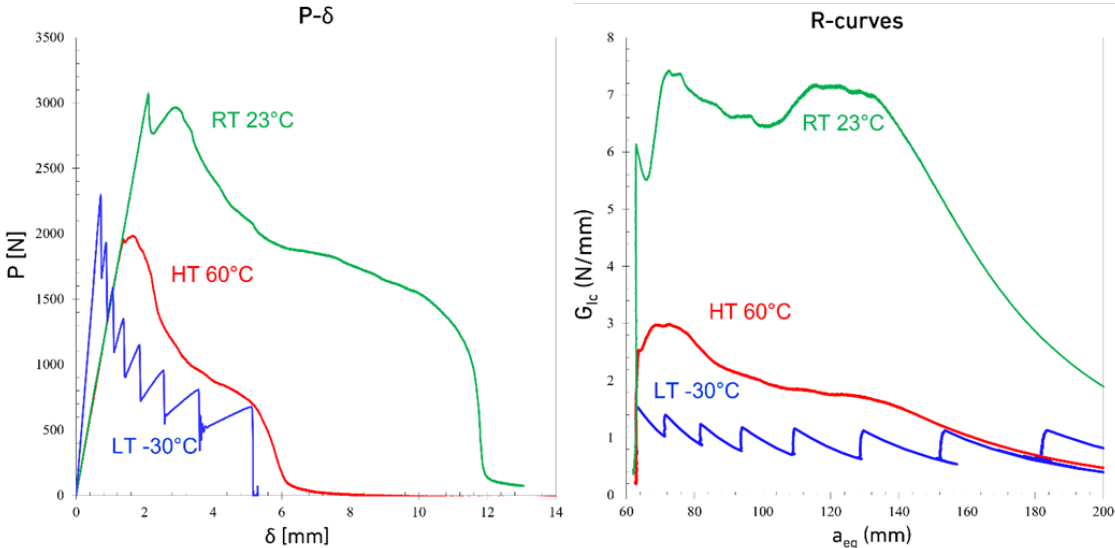
Figure 4. Representative Load-displacement and R-curves of DCB joints under speed loading rates (200 mm/min) at different temperatures.